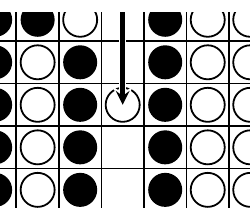
Figure 36. WHITE stops.